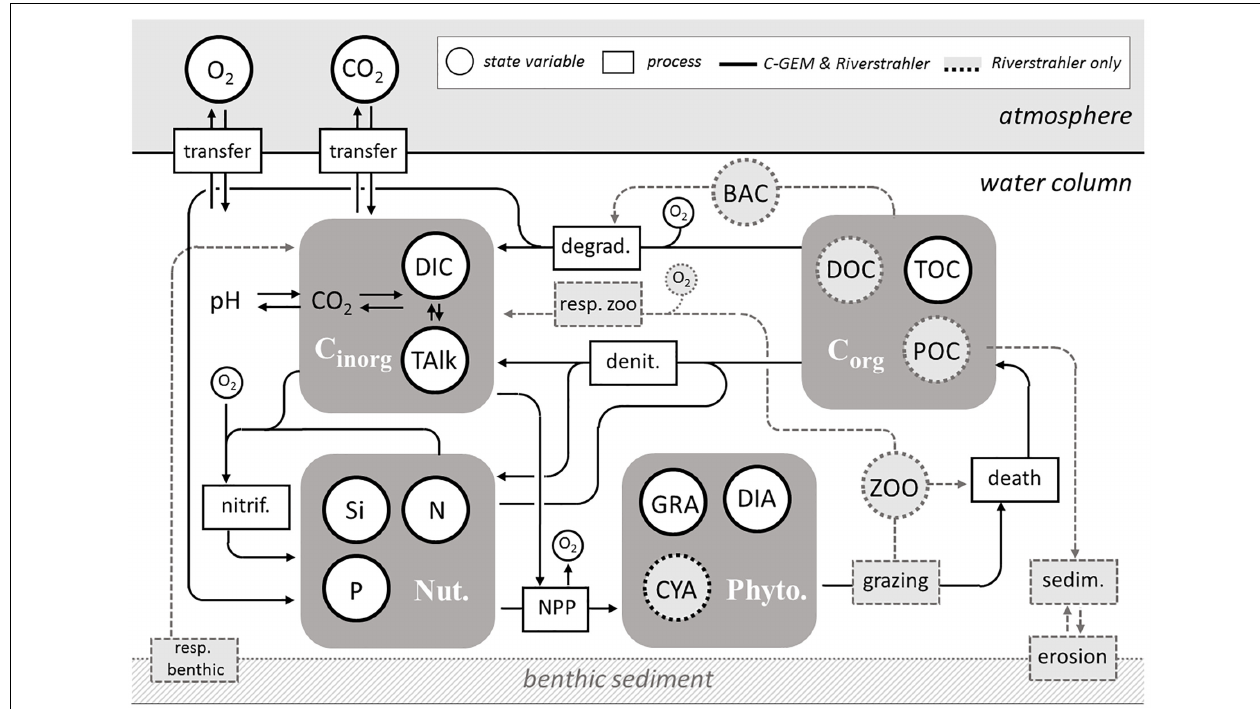
FIGURE 3 | Simplified conceptual scheme of the shared state variables and processes between C-GEM and Riverstrahler models. The two models simulate nutrients as N (NO 3 , NH 4 ), P (PO 4 , Total P), Si (DSi, BSi in Riverstrahler only). In the Riverstrahler, both dissolved (DOC) and particulate (POC) carbon are modeled according to three classes of degradability (rapid, slow, and refractory); heterotrophic bacteria (BAC) are described as large and small, and the zooplankton (ZOO) includes micro-crustaceans and rotifers-ciliates.